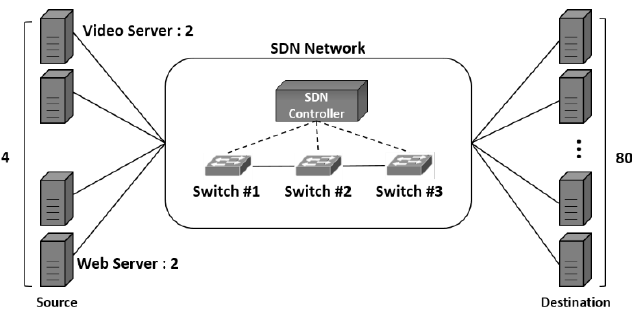
Figure 8. Topology configuration for evaluation.